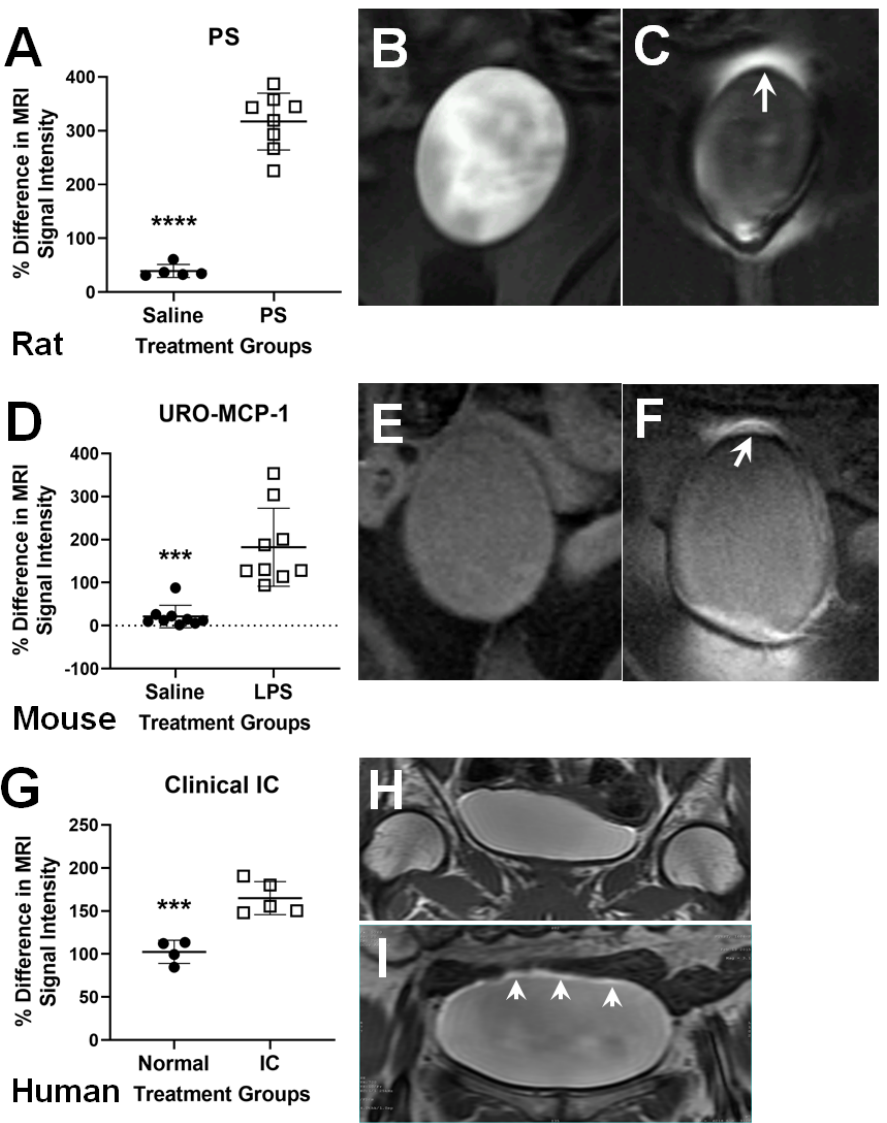
Figure 1. Bladder wall hyperpermeability CE-MRI in preclinical models and human IC/BPS. Rat protamine sulfate (PS)-induced BWH model ( A – C ). ( A ) Quantitative assessment of BWH in a rat PS-induced cystitis model treated with either saline (normal control; closed circles) or PS (open squares); 3 days post PS. There was a significant difference between the saline control and PS groups (**** p < 0.0001). ( B , C ) Representative CE-MR images of saline- ( B ) or PS- ( C ) rat bladders. White arrow in panel “C” depicts high MRI signal intensity (SI) due to BWH. Transgenic mouse IC/BPS model ( D – F ). ( D ) Quantitative assessment of BWH in a transgenic URO-MCP-1 mouse lipopolysaccharide (LPS)-induced IC model treated with either saline (normal control; closed circles) or LPS (open squares); 5 days post LPS. There was a significant difference between the saline and LPS groups (*** p < 0.001). ( E , F ) Representative CE-MR images of saline- ( E ) or LPS- ( F ) mouse bladders. White arrow in panel “F” depicts high MRI signal intensity (SI) due to BWH. Clinical IC/BPS patients ( G – I ). ( G ) Quantitative assessment of BWH in normal controls (closed circles) or IC patients (open squares). There was a significant difference between normal and IC groups (*** p < 0.001). ( H , I ) Representative CE-MR images of normal and IC patients. White arrow in panel “I” depicts high MRI signal intensity (SI) in bladder wall due to BWH. Figures were modified from those published in Refs. [28,38,39].